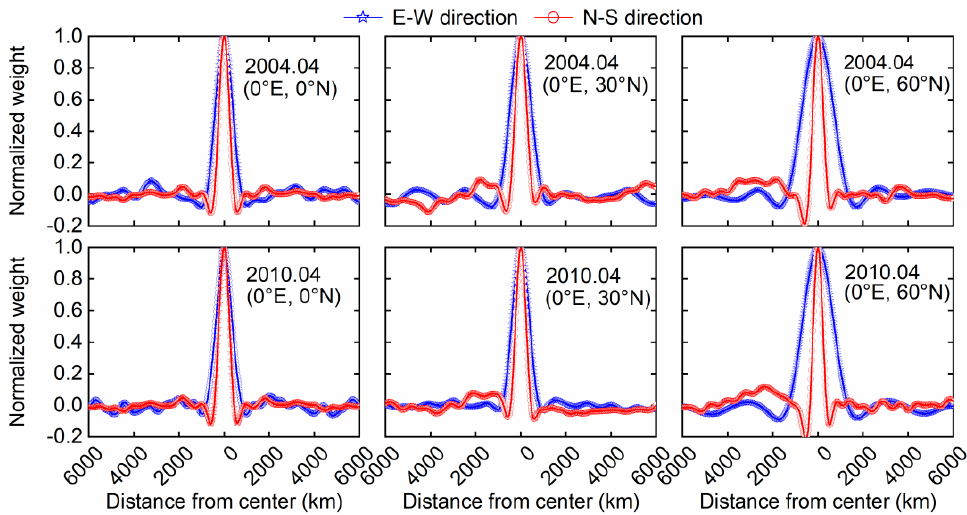
Figure 2. Cross-sections of normalized smoothing kernel of the proposed filter. Red: SN direction, Blue: WE direction. Top: April 2004; bottom: April 2010. Left: at (0° E, 0° N); middle: at (0° E, 30° N); right: (0° E, 60° N).